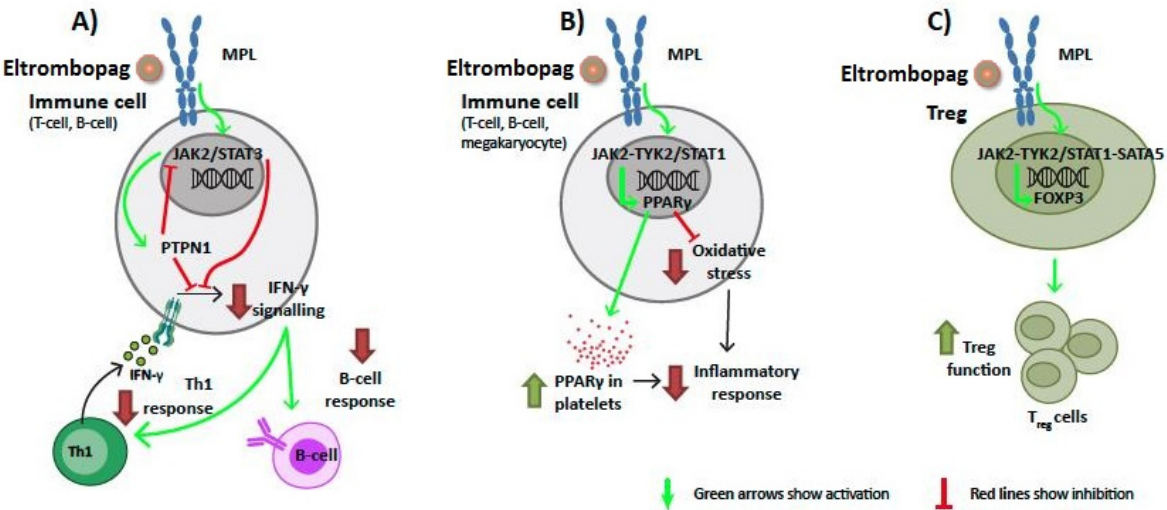
Figure 3. Predicted mechanism of action of eltrombopag affecting ( A ) IFN- γ signaling; ( B ) PPAR γ expression; and ( C ) FOXP3 activity in primary immune thrombocytopenia immune cells. Model path outputs can be found in Supplementary Figure S2B–D and scientific literature supporting the predicted mechanisms can be found in Supplementary Table S5. FOXP3: forkhead box protein P3; IFN- γ : interferon-gamma; MPL: thrombopoietin receptor; PPAR γ : peroxisome prolif- erator-activated receptor-gamma; PTPN1: tyrosine-protein phosphatase non-receptor type 1.